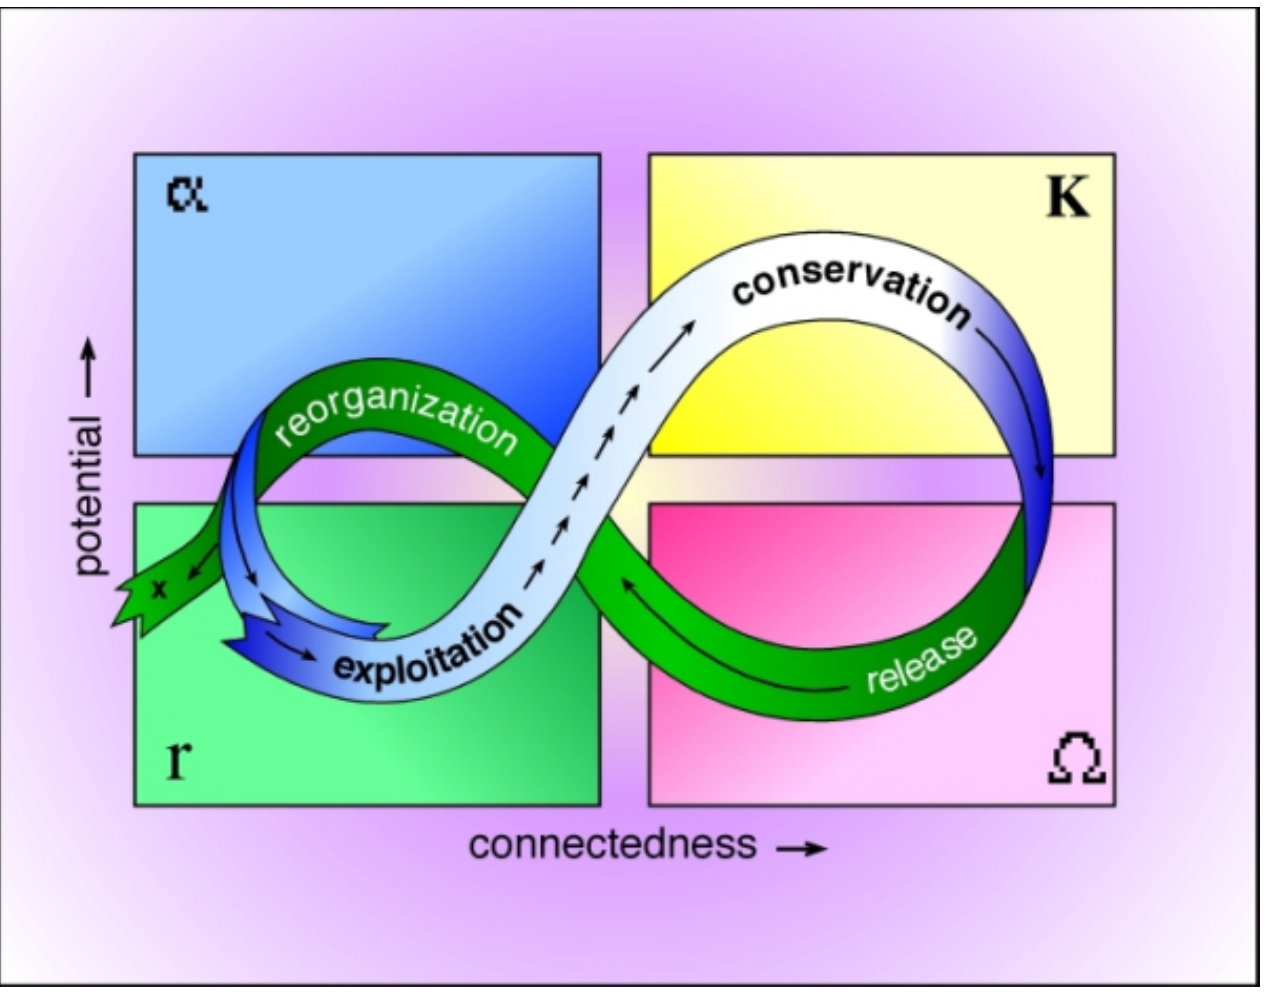
Fig. 1 . The four ecosystem functions (r, K, W , a ) and the flow of events among them. The arrows show the speed of that flow in the cycle, in which the arrows close to each other indicate a slowly changing situation. The cycle reflects changes in two attributes: (1) the y axis shows the amount of accumulated capital potential, e.g., nutrients, carbon, stored in the variables that are the dominant structuring variables at that moment, and (2) the x axis indicates the degree of connectedness among the variables. The arrows entering and leaving a phase suggest the points at which the system is most sensitive to external